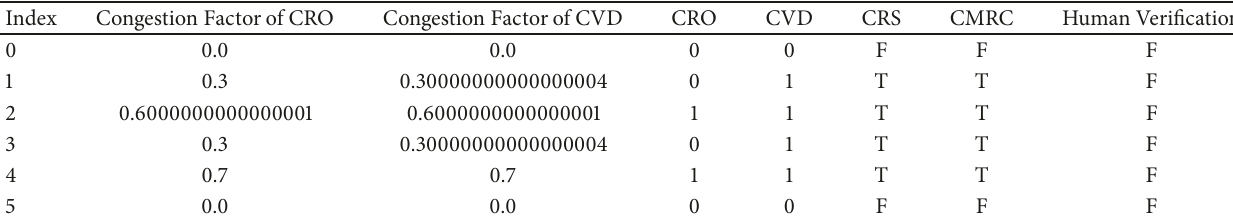
Table 7: Comparison result for road 188982779#3 in Karamay City, China.